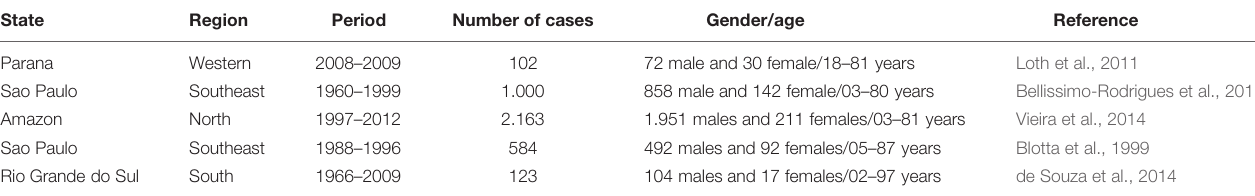
TABLE 1 | Occurrence of paracoccidioidomycosis in the Brazilian territory raised by eco-epidemiological